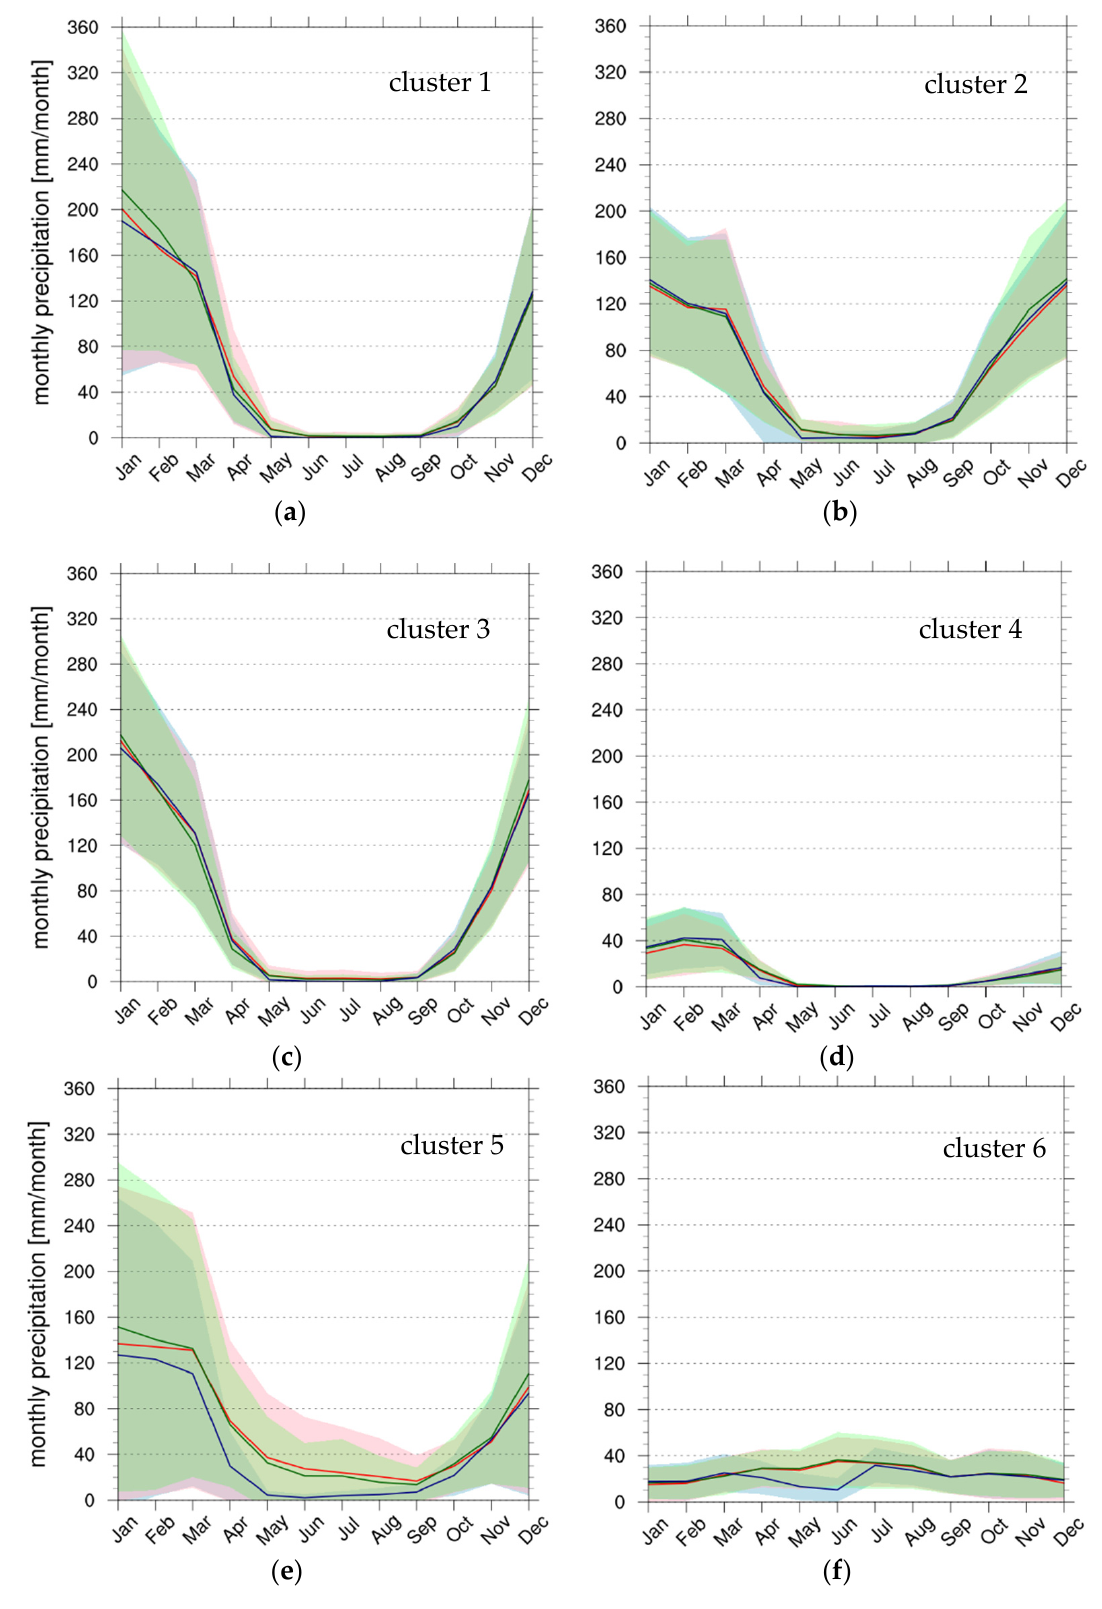
Figure 9. Same as in Figure 6 but for SA, from cluster 1 ( a ) to cluster 6 ( f ).